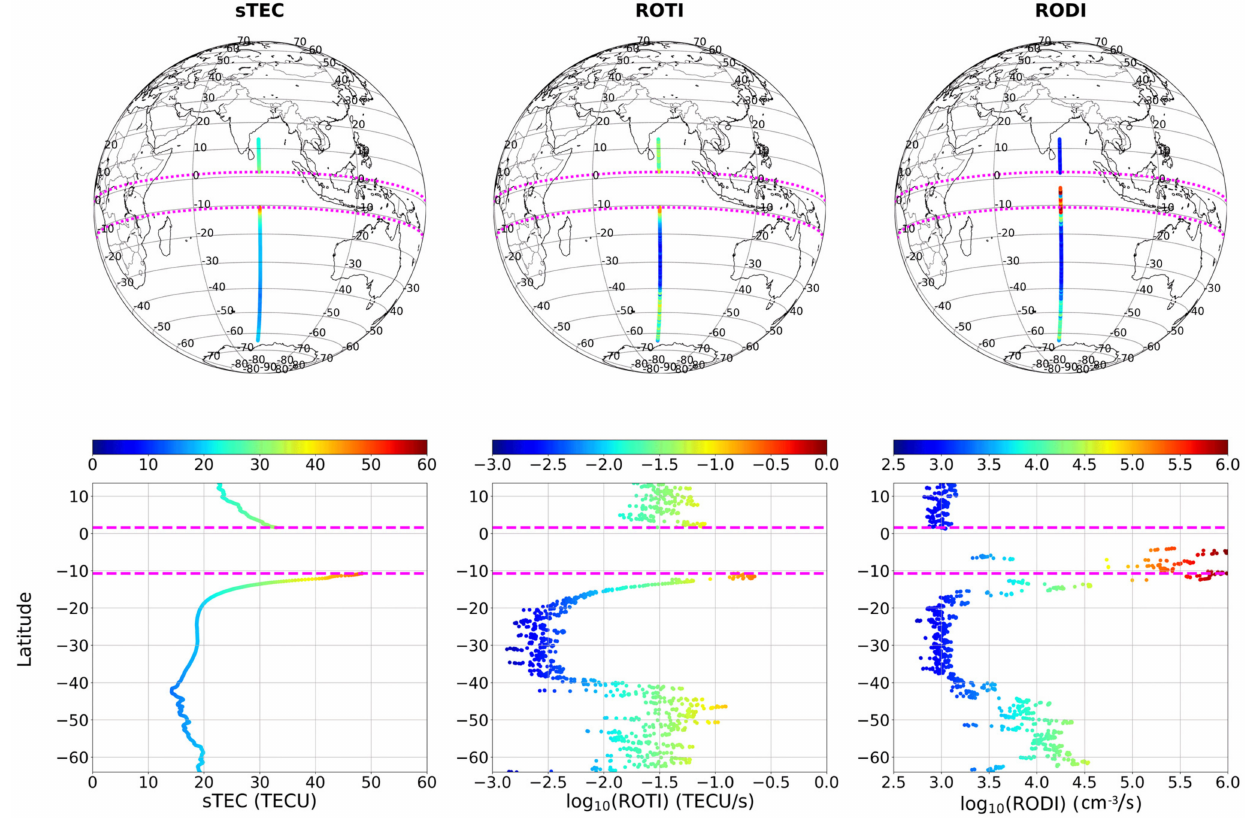
Figure 1. Example of GPS LoL event identified at around 14 UT by Swarm A during its ascending orbit between 13:46:35 and 14:06:50 UT on 17 March 2015 and related to PRN = 9. Magenta curves identify the GPS LoL duration, that in this case is of 191 s. Left, middle, and right panels refer respectively to sTEC, ROTI, and RODI. Upper panels represent the values in geographic coordinates, while the lower ones show the corresponding plots latitude vs. value. 1 TEC unit (TECU) = 10 16 electrons/m 2